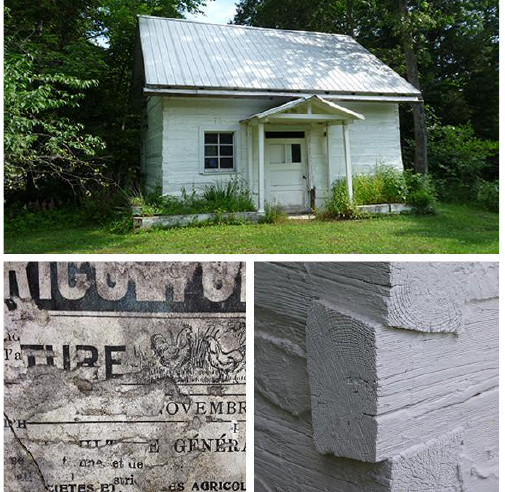
Figure 1. Breard Log House – Newspaper (1899) – Cornerwork